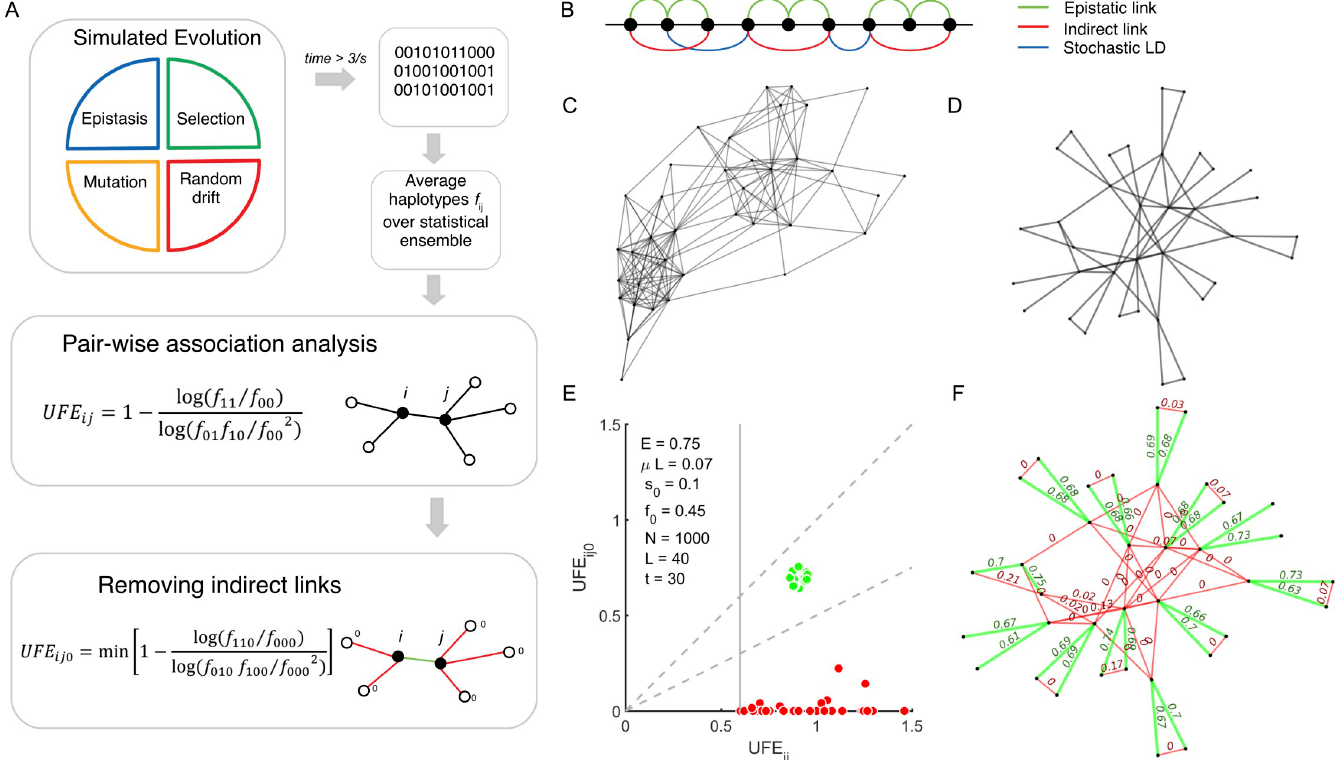
Fig 1. Schematic diagram of the method and its testing on simulated sequence data. A . The computer model of asexual evolution includes the factors of random mutation, selection, epistasis, and random genetic drift. Pairwise haplotype frequencies f are averaged over simulation runs (independent populations). The pairwise ij correlation measure UFE ij is calculated from Eq 1. The indirect links and the residual linkage are detected and filtered out by using the tri-way correlation measure, UFE ij 0 , from Eq 2. B. Pre-set epistatic network for 50 sites. Green curves: real epistatic interactions. Red lines: indirect interactions. Blue lines: examples of stochastic linkage effects. C-D. The network of strong ( UFE > 0.5) candidate epistatic interactions predicted ( C ) from a single population and ( D ) after averaging over 200 ij populations. E. Scatter plot of the three-way haplotype, min ( UFE ij 0 ) shown against UFE ij for the pairs identified in ( D ). The dashed sector corresponds to the direct interactions. The upper dashed line is the diagonal, UFE = UFE , and the lower dashed line separates direct and indirect interactions. F. Predicted network accurately ij ij 0 recapitulates the pre-set epistatic network. Parameters: initial allele frequency f 0 = 0.45, mutation rate per genome μL = 0.07, fixed selection coefficient s = 0.1, N = 1000, L = 40, epistatic strength E =